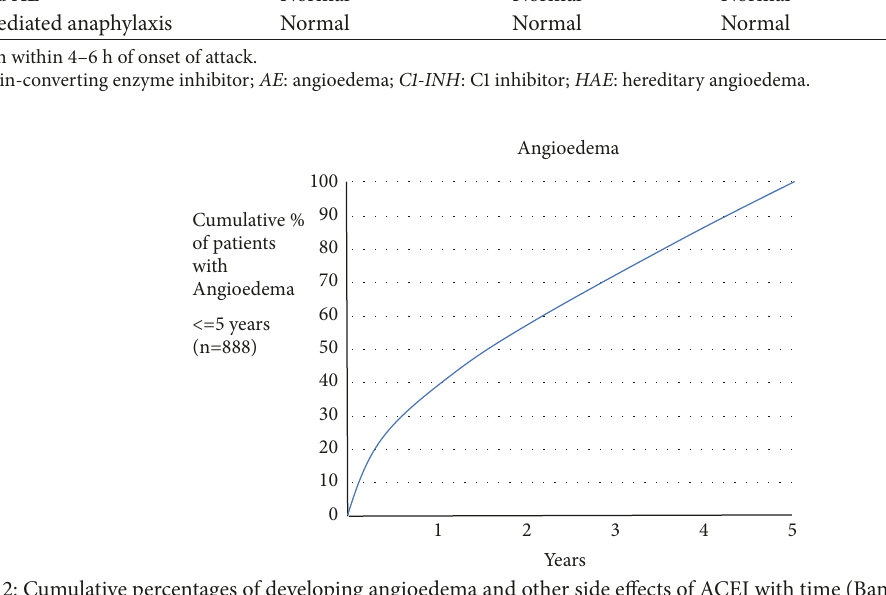
Normal Normal Normal or Elevated